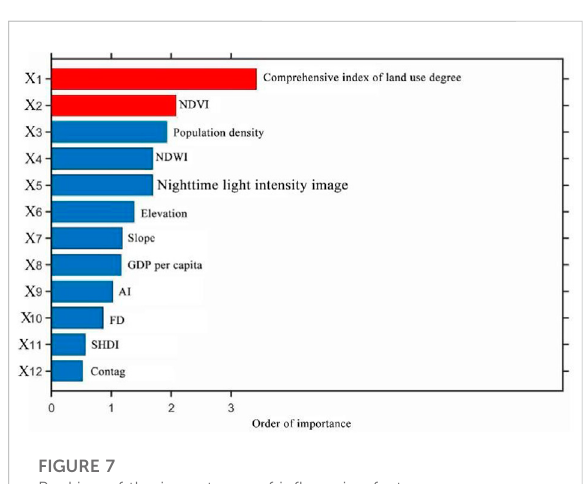
FIGURE 7 Ranking of the importance of in fl uencing